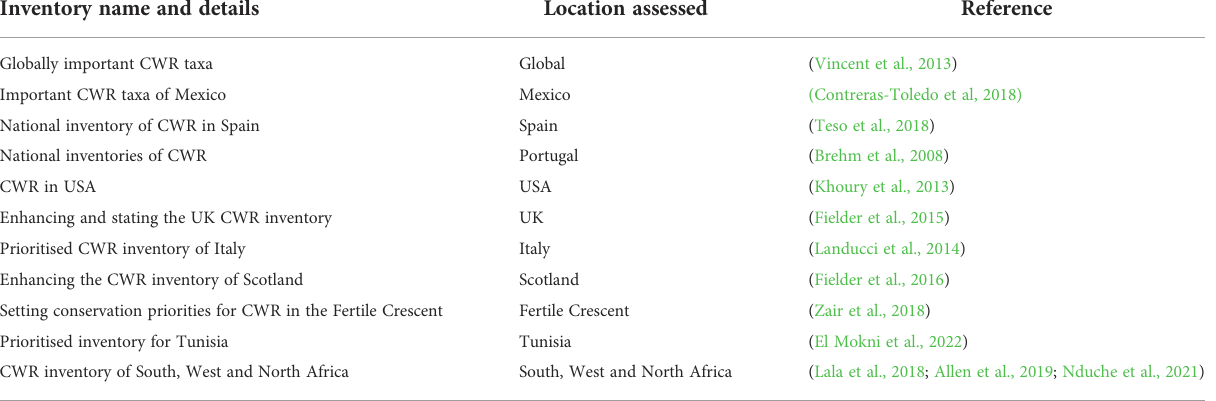
TABLE 2 A list of major global and national CWR plant